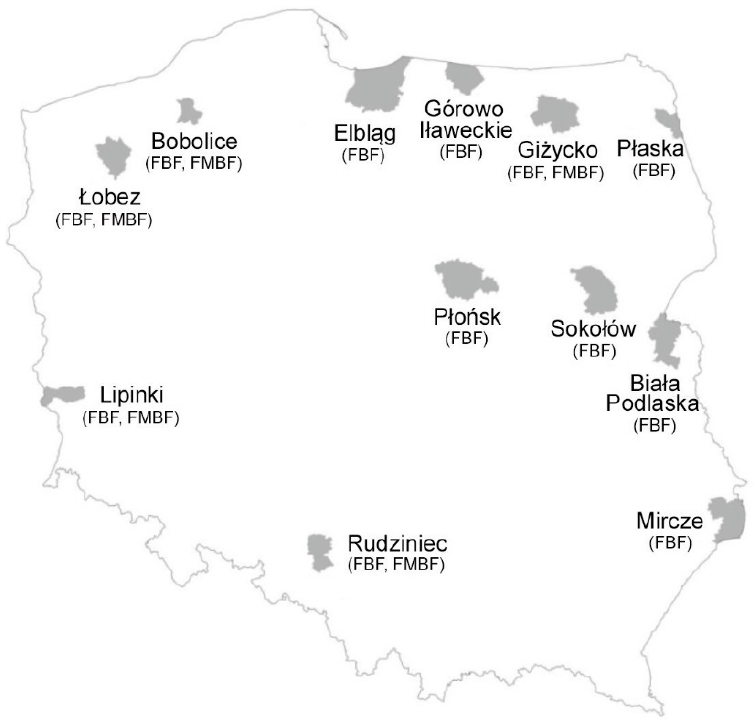
Figure 1. Geographical distribution of the forest districts where the test plots were located [26].